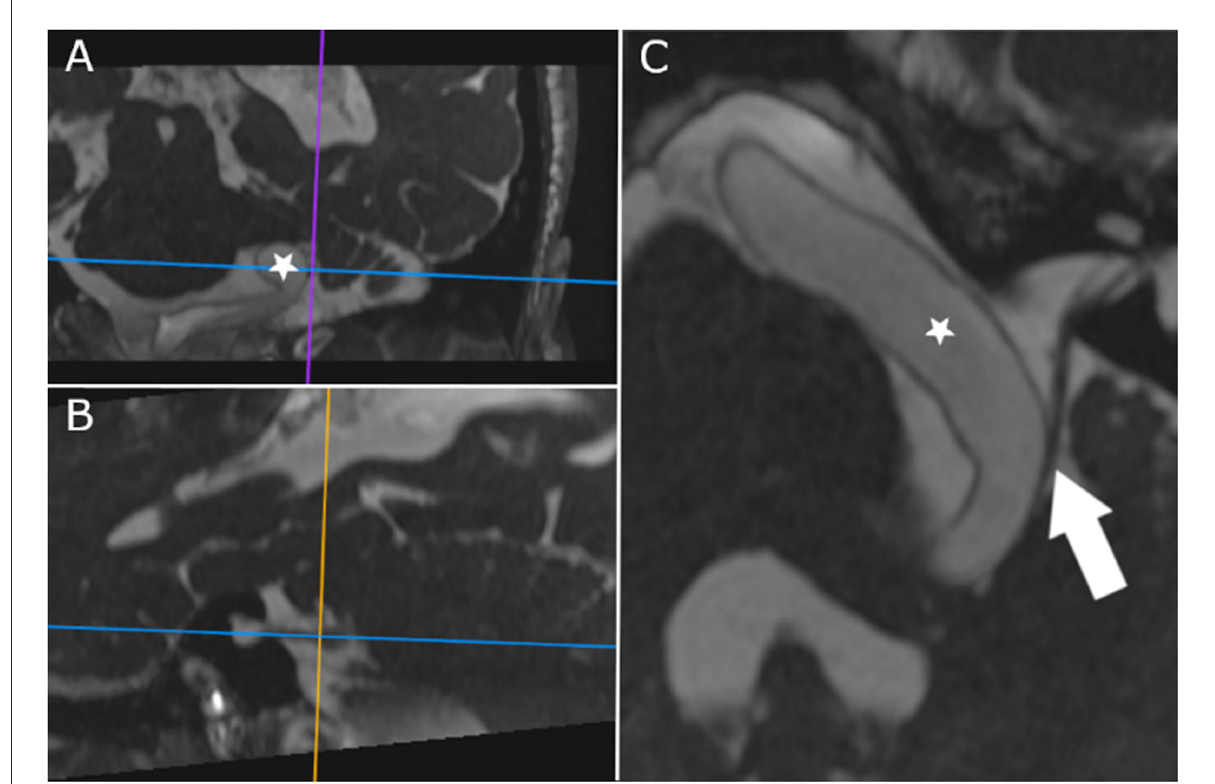
FIGURE1 CISS-MRI in oblique axis reconstructed along the cisternal course of the vestibulocochlear and facial nerves (the horizontal line in (A,B) depicts the axis of (C) ; vertical lines delineate the axis of the other planes, (A,B) , respectively; lines are centered on contact point of the vestibulocochlear nerve and the basilar artery). The dilated and elongated basilar artery (star) displaces the nerves, and direct contact is shown